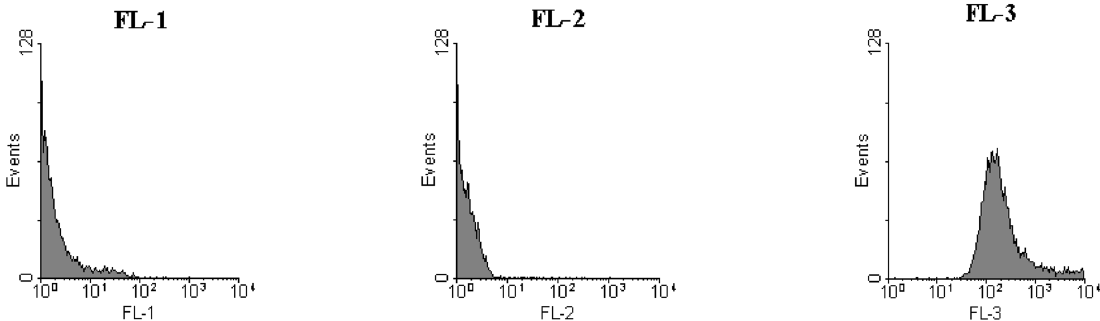
Figure 1. Dyed styrene microspheres were evaluated by flow cytometry. The fluorescence of these microspheres appears in fluorescence channel 3 (FL3), but not in FL1 or FL2.